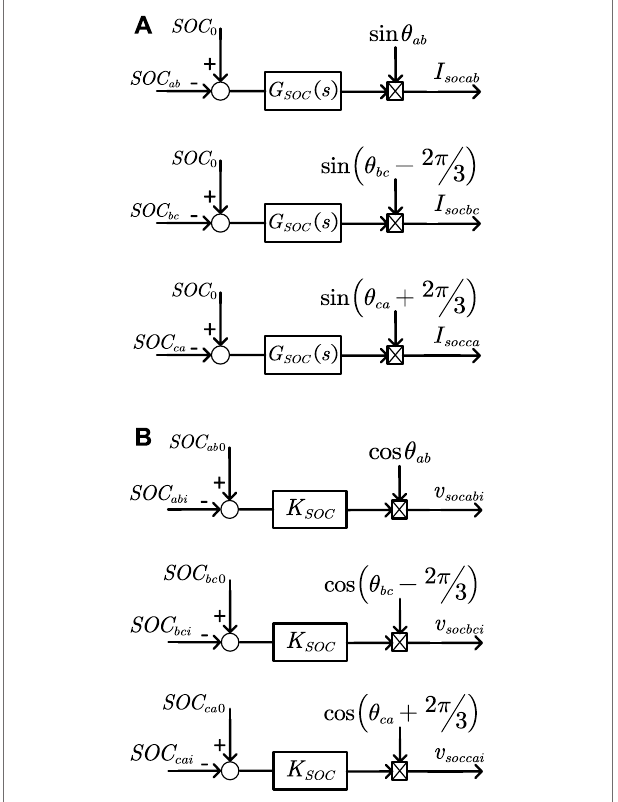
FIGURE 6 | STATCOM/BESS SOC equalization control: (A) phase-to- phase SOC equalization control and (B) in-phase sub-module SOC equalization